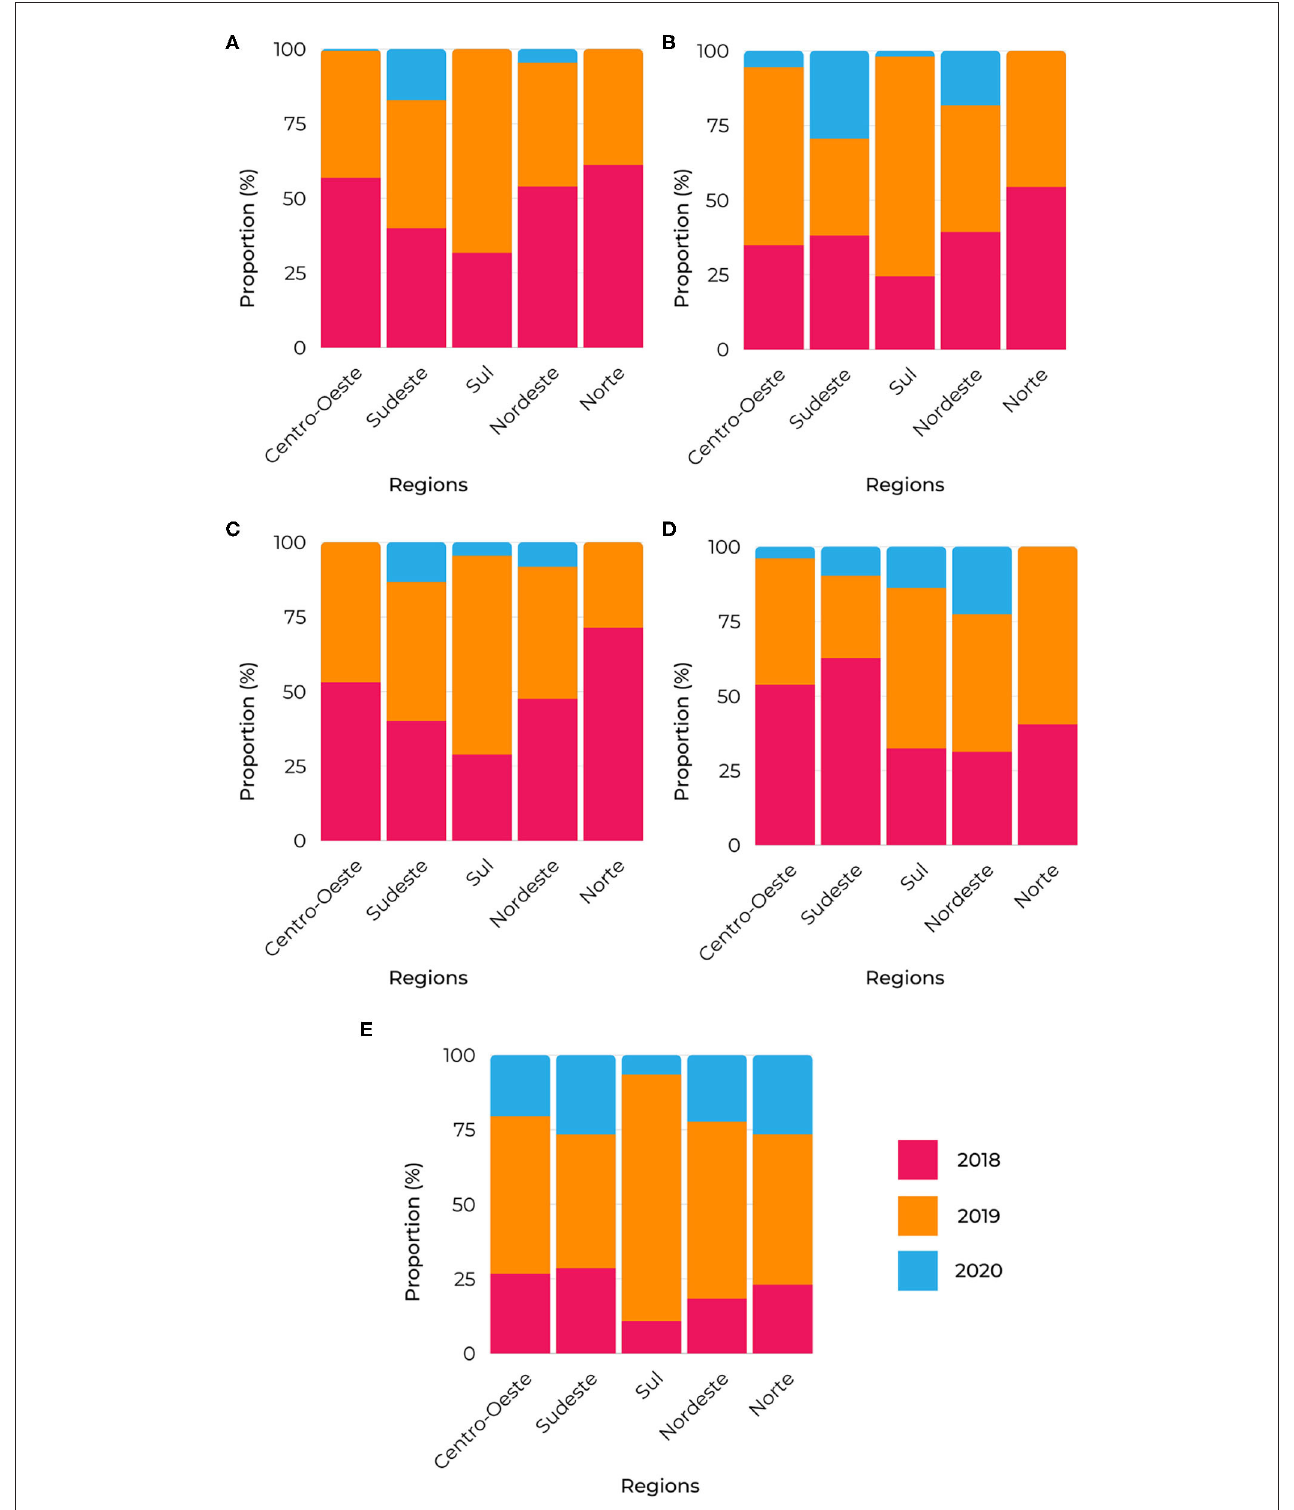
FIGURE 6 | Bigrams proportion of relevant terms segmented by region. (A) primary care, Confronting syphilis, syphilis cases and prenatal care; (B) care networks, health units, women’s health and pregnant syphilis; (C) investigation transmission, syphilis territory, and congenital syphilis; (D) municipal plan, epidemiological surveillance, and health surveillance; (E) rapid testing and diagnosis